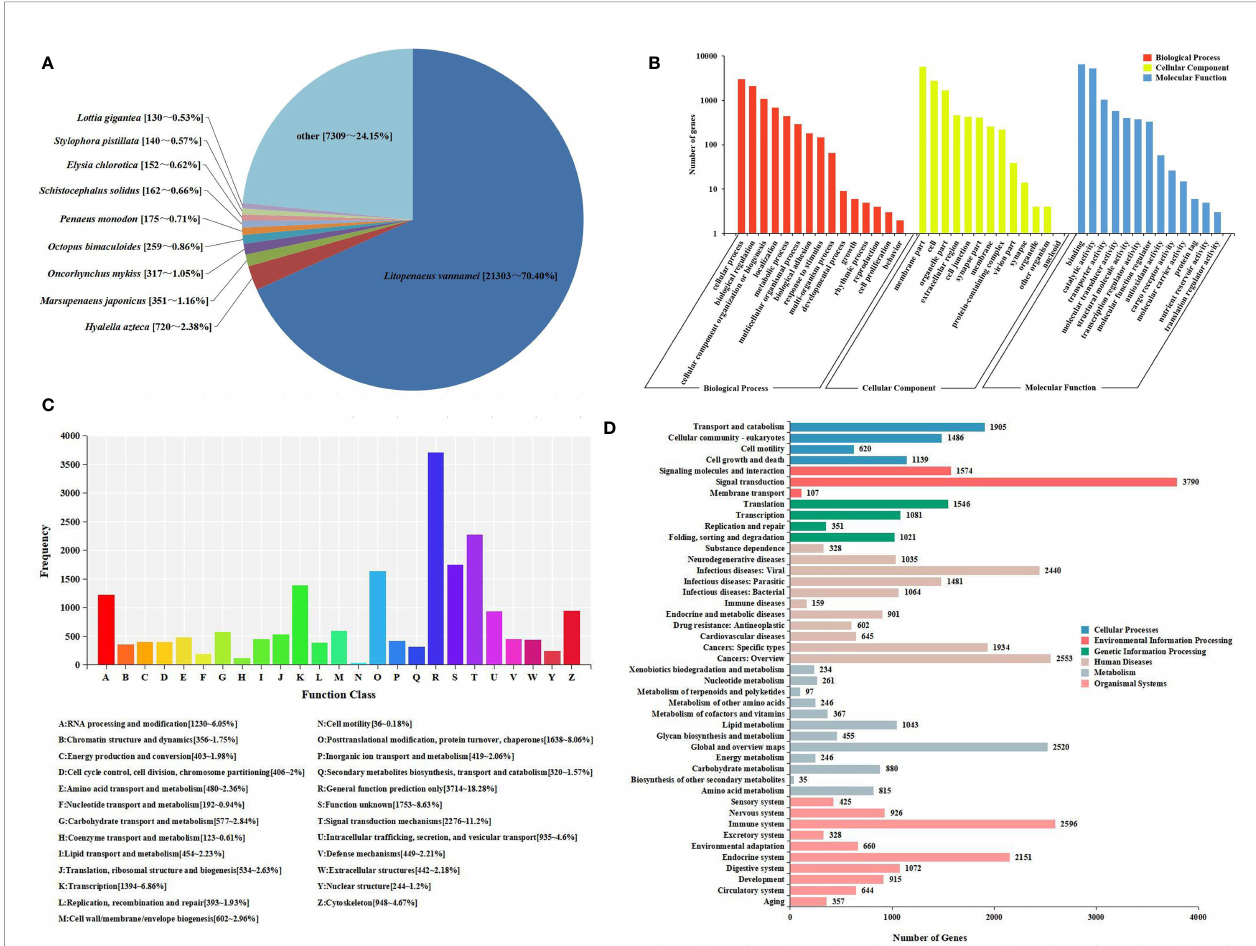
FIGURE 2 | Sequence analysis and functional annotation of assembled unigenes identi fi ed from the Marsupenaeus japonicus intestine under DIV1 infection. (A) Species distribution of the BLASTx matches of the transcriptome unigenes. This fi gure shows the species distribution of unigene BLASTx matches against the Nr protein database and the proportions for each species. (B) GO terms (level 2) and annotation of the integrated transcriptome assembly. The x-axis indicates 3 GO categories with 41 subcategories, and the y-axis indicates the number of unigenes. (C) KOG function classi fi cation of unigenes. Each bar represents the number of unigenes classi fi ed into each of the 25 KOG functional categories. The x-axis represents the functional categories, and the y-axis represents the frequency. (D) KEGG biological pathway classi fi cation histograms for annotated unigenes. Each bar represents the number of unigenes classi fi ed into different biological processes. The x-axis shows the number of the matched unigenes, and the y-axis shows the pathways from the KEGG classi fi cation. DIV1, decapod iridescent virus 1; GO, Gene Ontology; KEGG, Kyoto Encyclopedia of Genes and